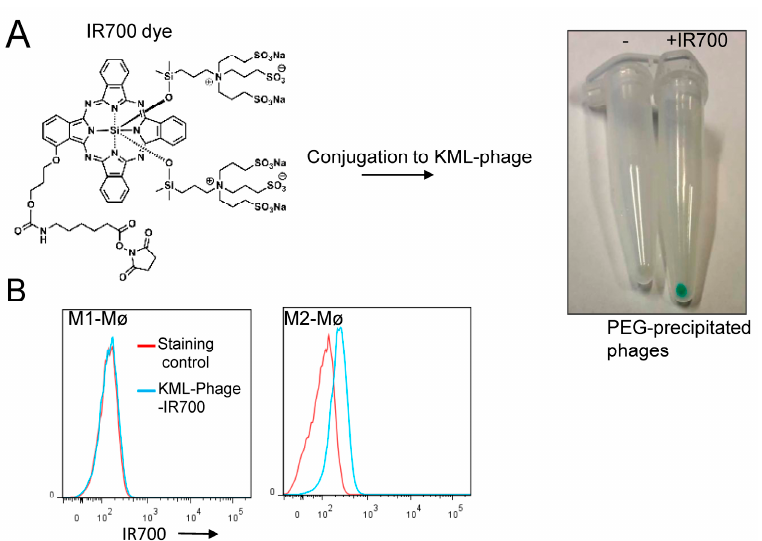
Figure 7. Conjugation of the phages to IR700 photosensitizer. ( A ) Chemical structure of the IR700 photosensitizer. After PEG precipitation, a picture was taken to illustrate the conjugation of the IR700 dye to the phage particles. ( B ) Flow cytometry analysis of the conjugate binding to M1 and M2 macrophages. The cells were -incubated with the conjugate (10 7 TU/mL) and then analyzed by flow cytometry.